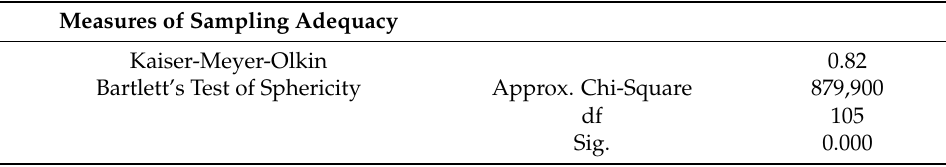
Table 3. Measures of Sampling